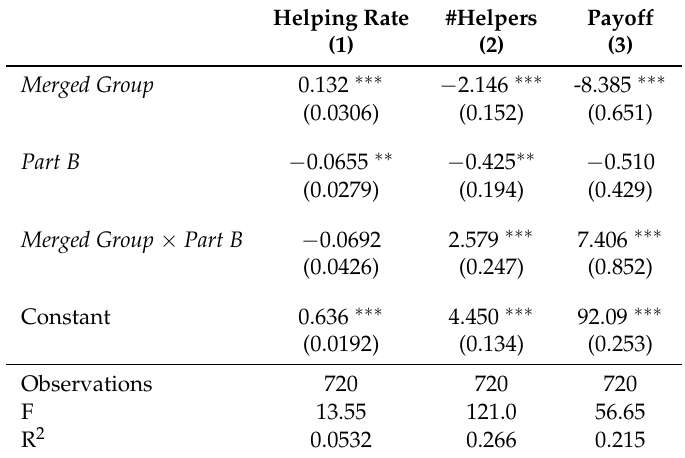
Table A2. Difference-in-difference regressions: helping rates, #Helpers and